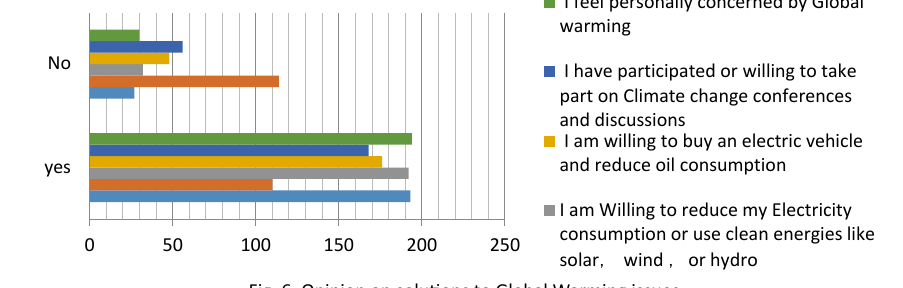
Fig. 6: Opinion on solutions to Global Warming issues Table 4: Opinions on Global Warming Solutions (N=224)